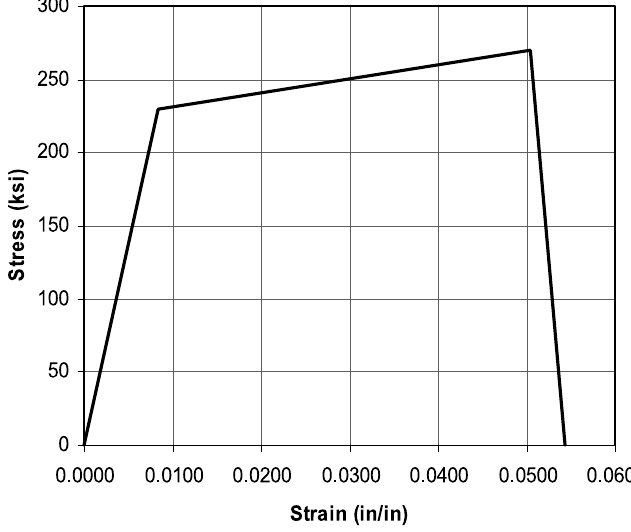
Fig. 5. Prestressing Steel Material